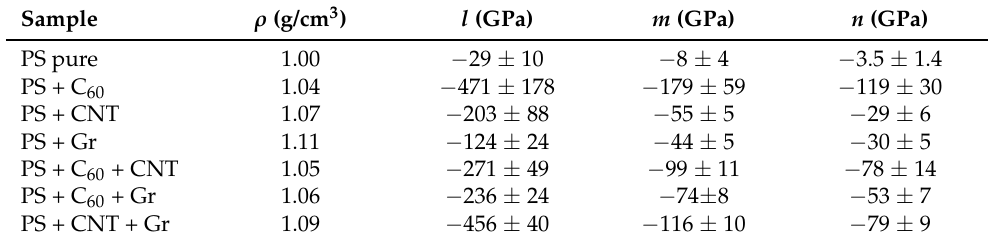
Table 2. Nonlinear elastic moduli of PS-based nanocomposites obtained from ultrasonic measurements.